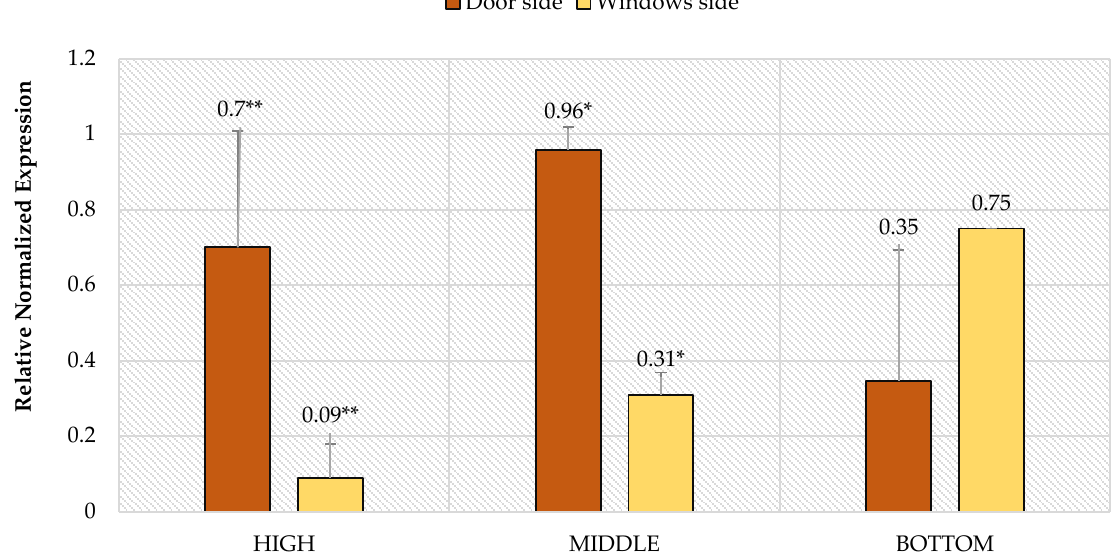
Figure 5. Level of relative normalized expression (RNE) of Actinobacteria phylum depending on the cage setting. ** p = 0.00427; * p = 0.046.